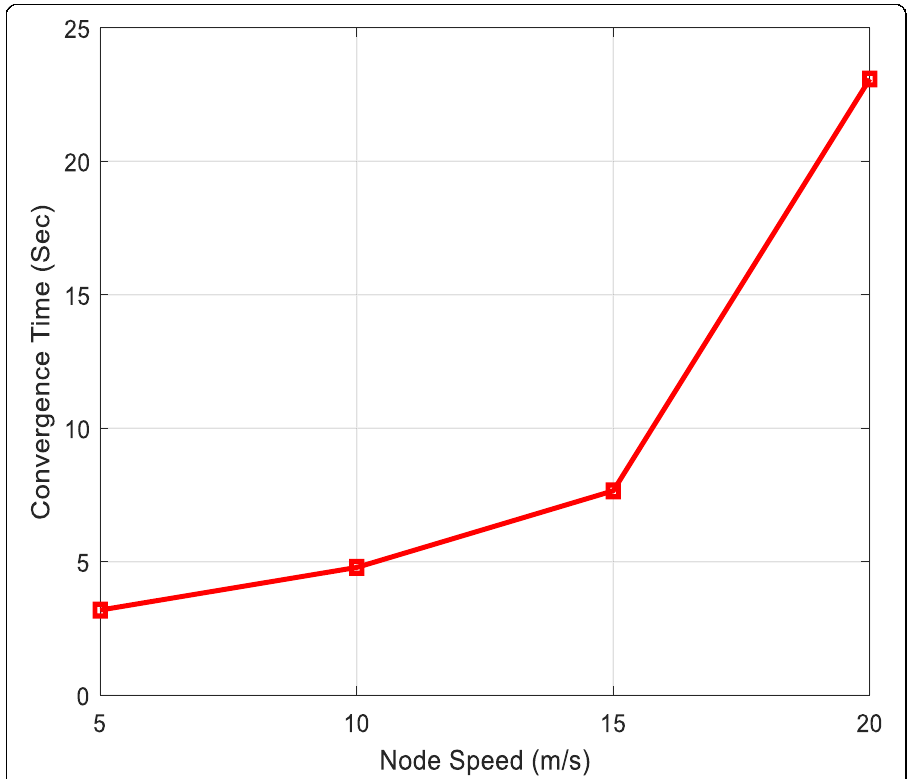
Fig. 14 Convergence time of proposed MET-MFODSR scheme versus the node speed. The simulation results of the convergence time of the MET-MFODSR algorithm using the CRAWDAD dataset concerning node speed